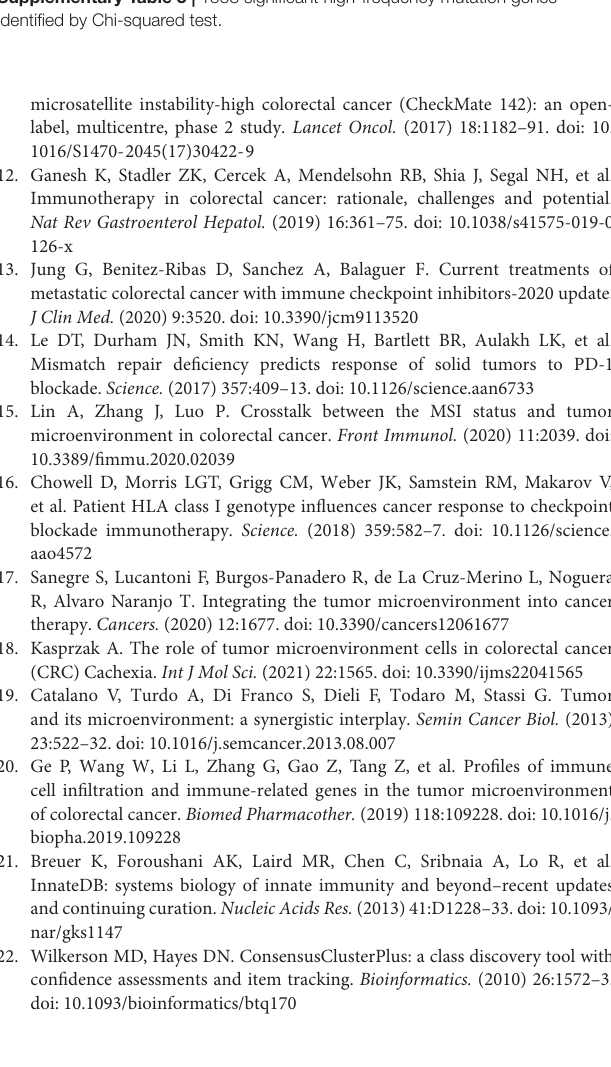
Supplementary Table 1 | A total of 2,006 immune-related genes. Supplementary Table 2 | 275 immune-related genes with significant differences in the